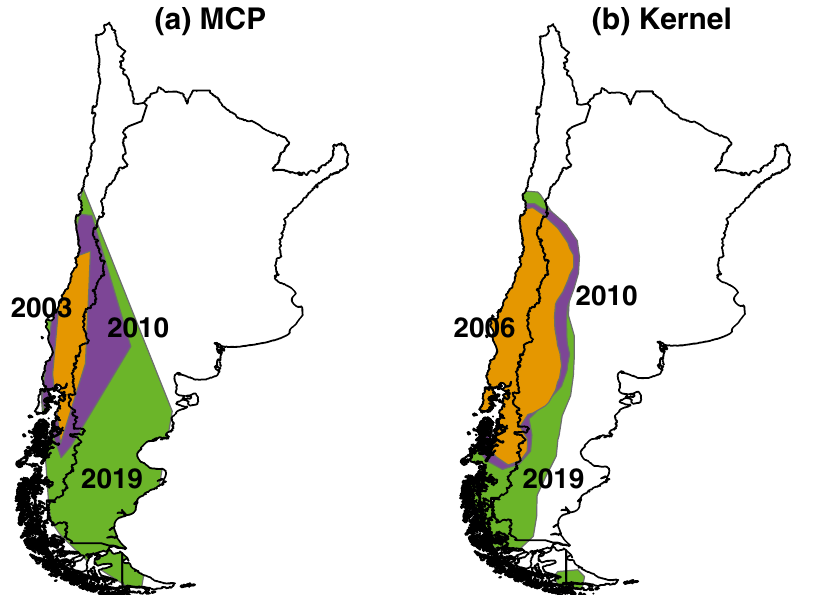
Figure 3. Bombus terrestris area in three different times, using both minimum convex polygon (MCP) and 95% fixed kernel (FK) estimators. (this map was created by FEF in QGIS 3.18 [www. qgis. org], using our own